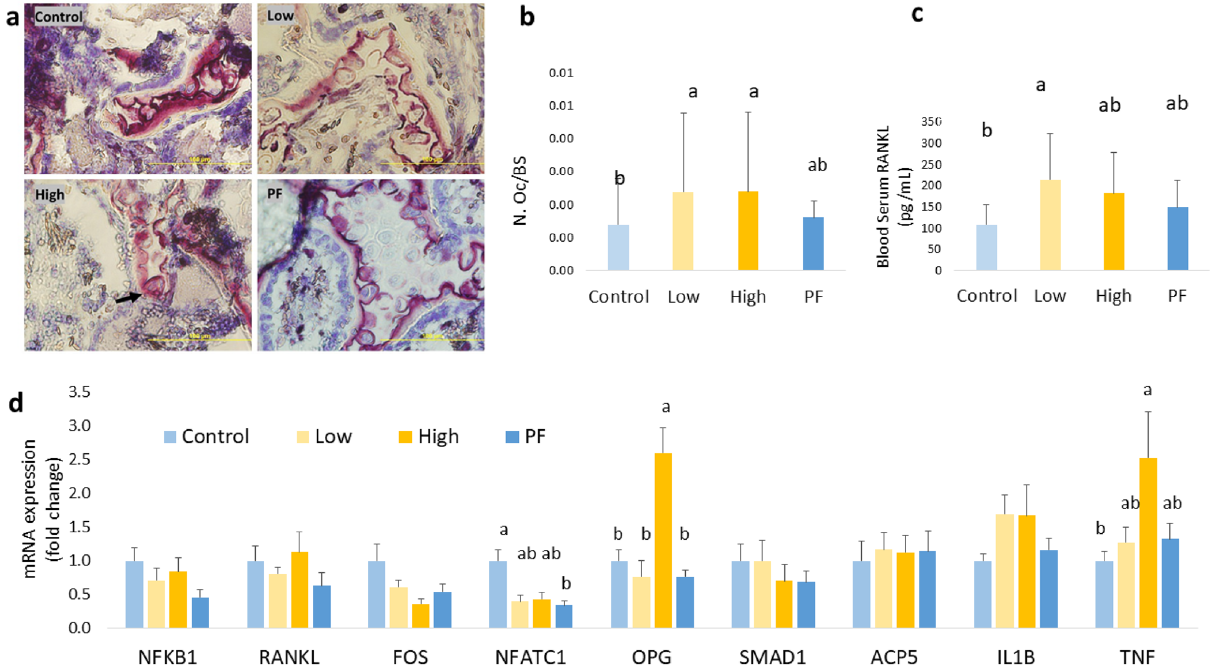
Figure 4. Eimeria infection increases osteoclast formation. ( a ): Illustration of TRAP staining at tibial metaphysis section. Osteoclasts were defined in this study as TRAP-positive cells with three or more nuclei. Osteoclast was indicated with arrow. Photos were taken at 10 × objective. The yellow scale bar is 100 µm in length. ( b ): Number of osteoclasts (N. Oc) were counted and bone circumference (BS) were measured. The increased ratio of N. Oc/BS indicated an increased formation of osteoclast activity at metaphysis section in Eimeria infected groups ( P = 0.004). ( c ): Serum level of RANKL in broilers at 6 dpi. The low group has higher level of RANKL than the Control group ( P = 0.047). ( d ): Osteoclastogenesis-related gene expression in broilers bone marrow of different treatment groups. a,ab,b Treatments with different letters means a significantly difference between treatments by using Tukey’s HSD test, P < 0.050, N = 10. Control, non-challenge control group; Low, the low challenge dose of Eimeria ; High, the high challenge dosage of Eimeria ; PF, pair-feeding group that paired with High group.